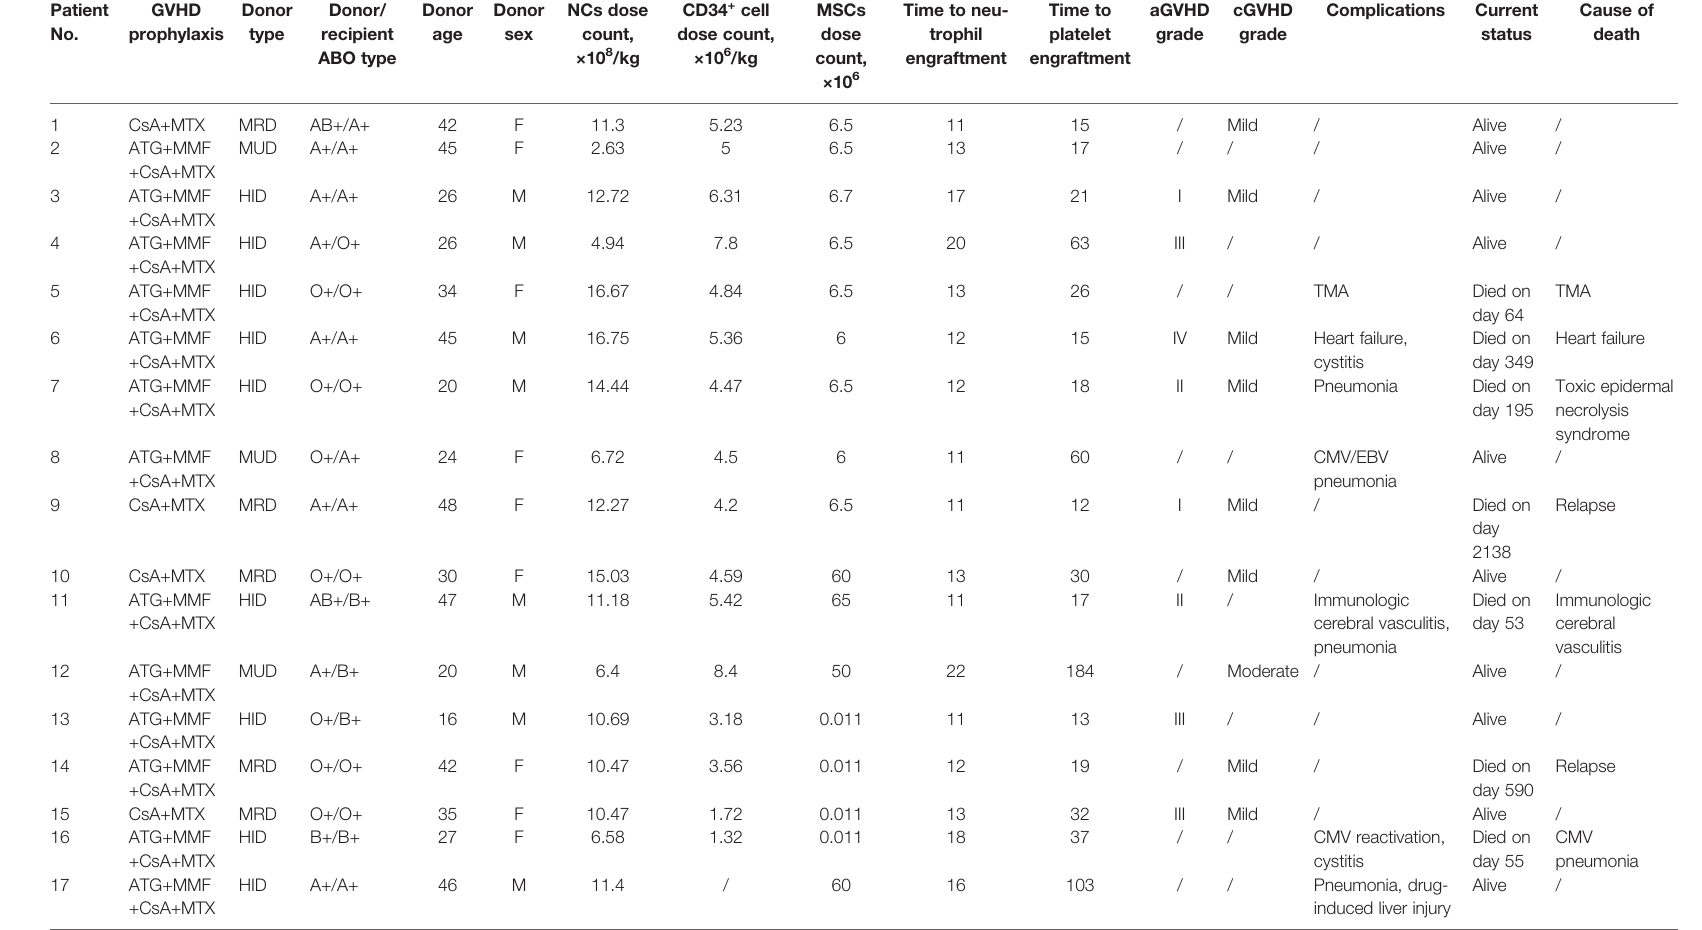
GVHD, graft-versus-host disease; CsA, cyclosporine A; ATG, antithymocyte immunoglobulin; MMF, mycophenolate mofetil; MTX, methotrexate; F, female; M, male; MRD, matched related donor; MUD, matched unrelated donor; HID, haploidentical donor; NCs, nucleated cells; MSCs, mesenchymal stem cells; CMV, cytomegalovirus; EBV, Epstein – Barr virus; “ / ” , not occurred; TMA, thrombotic